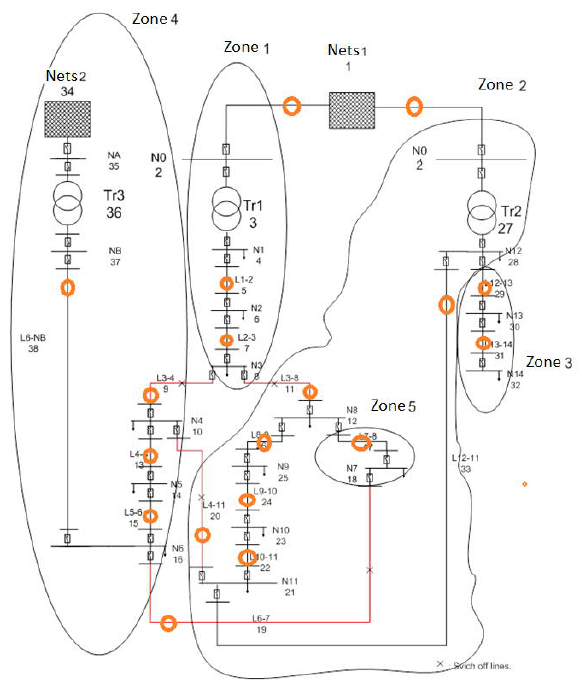
Fig. 4. Distribution network divided into operating areas with sites for installation of current and voltage